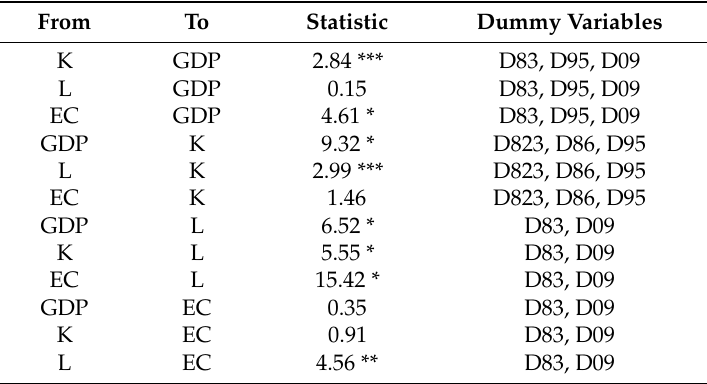
Table A2. Toda and Yamamoto causality test results: Aggregated level.